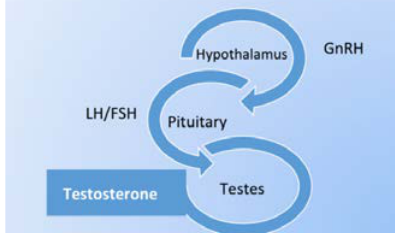
Figure 1. Hypothalamic regulation of